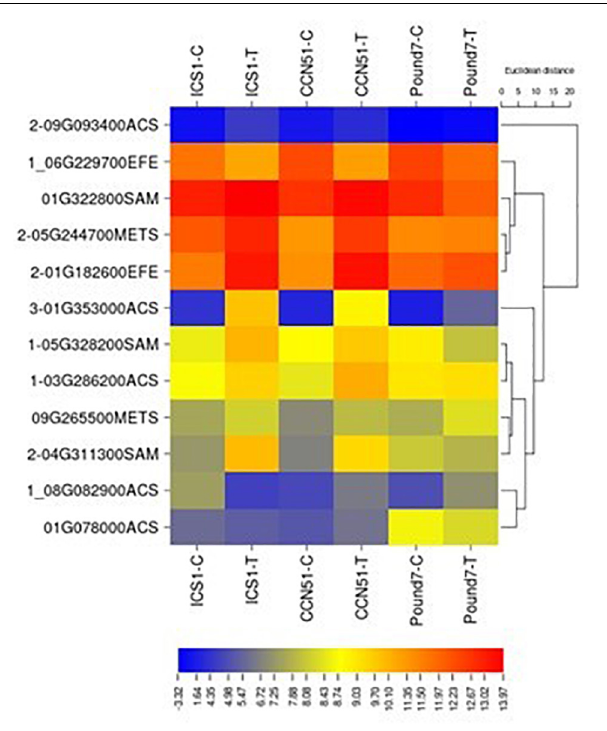
FIGURE 6 | A heat map displaying relative expression levels of cacao genes involved in ethylene biosynthesis (M00017) in young red leaves of genotypes ICS1, CCN51, and Pound7 24 h after inoculation with 20- µ l drops of zoospores (0.6 × 10 5 zoospores/ml). Initial numbers indicate the number of genotypes with significant differential expression between treated and control samples, while genes lacking initial numbers were not differentially expressed. The following – and _ indicate upregulated, downregulated genes, respectively. The following numbers represent gene identifications in the cacao transcriptome ( Supplementary Data Sheet 1 ). Terminal letters indicate the pathway step. ACS, synthase; EFE, aminocyclopropanecarboxylate